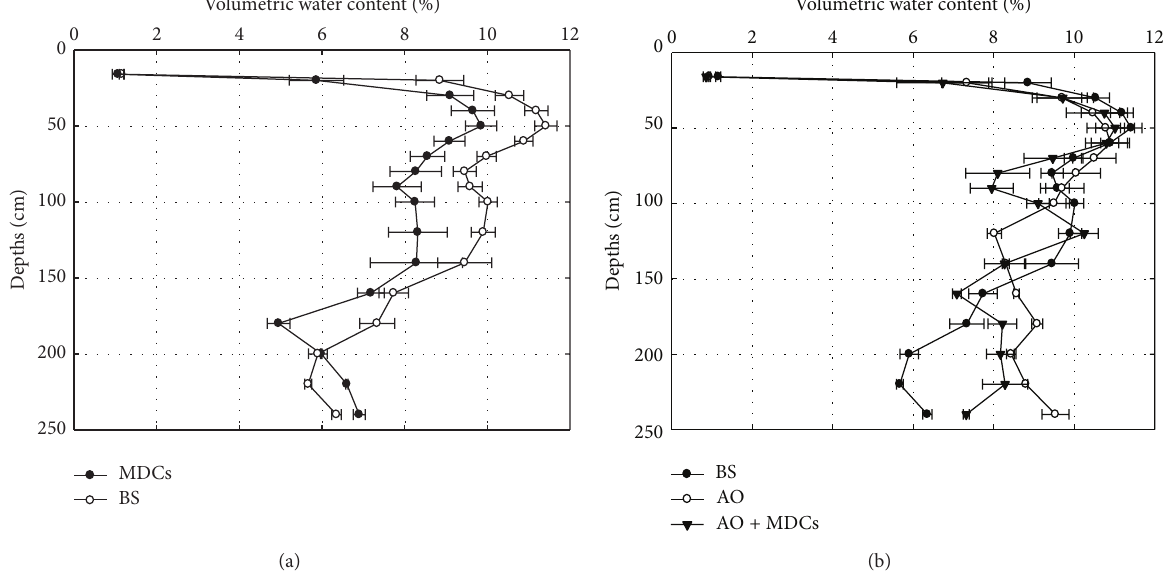
Figure 5: Volumetric water content from 10cm to 240 cm of bare sand plots (BS), moss-dominated crusts plots (MDCs), Artemisia ordosica plots (AO), and Artemisia ordosica combined with moss-dominated crusts plots (AO + MDCs) in the dry season (April to May).